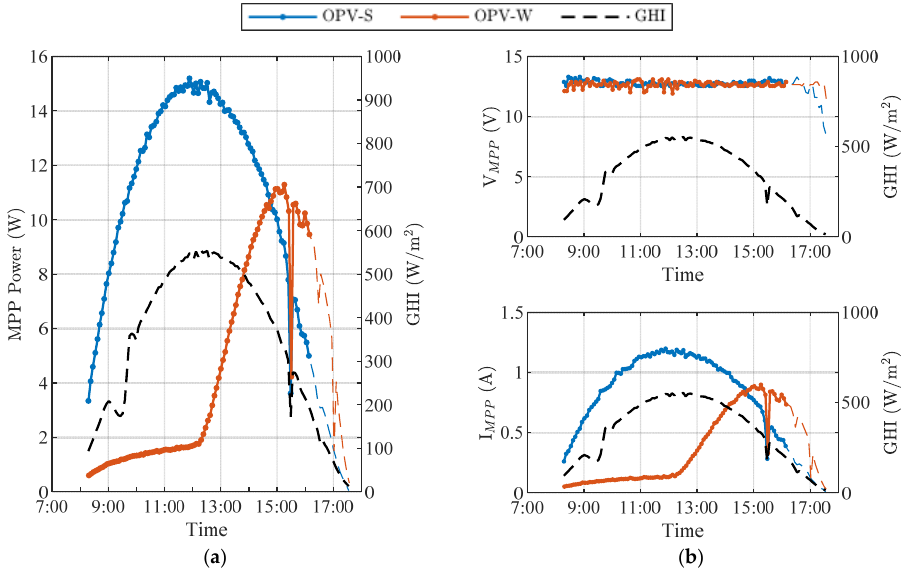
Figure 9. Example of raw data on a sunny day: ( a ) maximum power, P mpp ; ( b ) its coordinates, V mpp and I mpp , recorded on 11 February 2021.